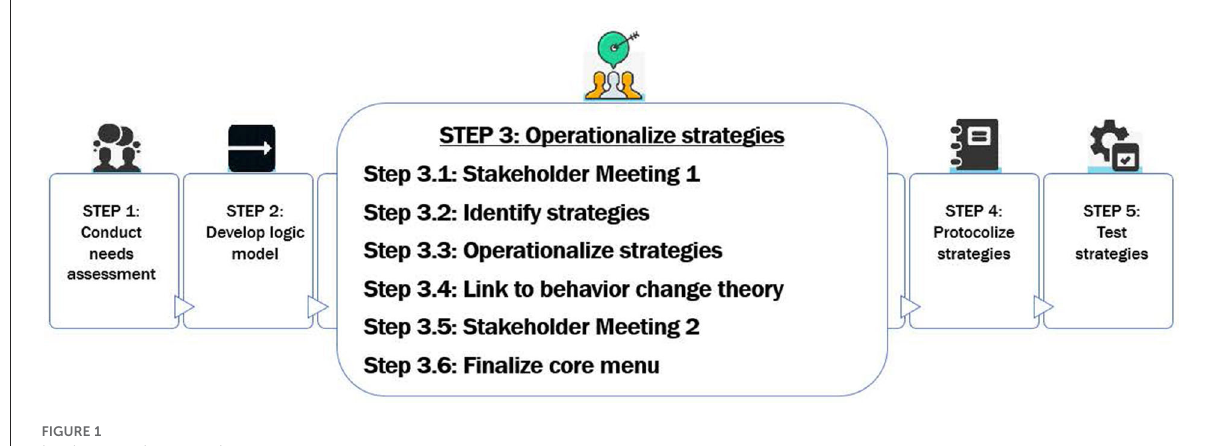
FIGURE1 Implementation mapping